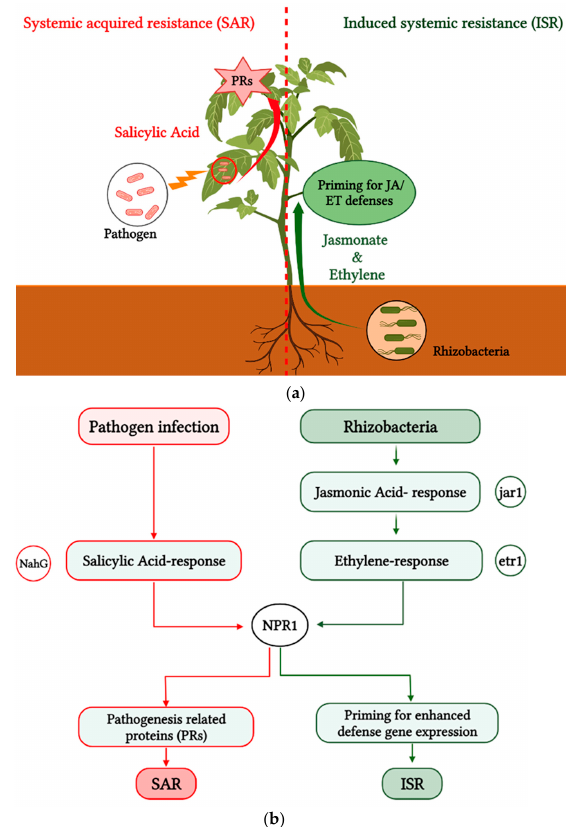
Figure 5. Schematic illustration of induced immune responses: ( a ) an image represents systemic acquired resistance (SAR), which is triggered after local infection of plants by phytopathogens. SAR provides resistance to biotic and abiotic stresses; whereas induced systemic resistance (ISR) is activated by plant growth-promoting rhizobacteria (PGPR) and confers resistance to biotic stresses. ( b ) a flowchart shows the signal transduction pathway of SAR, which relies on the salicylic acid (SA) pathway, encoded by NahG, while ISR involves jasmonic acid and Ethylene, encoded jar1, and etr1, respectively.